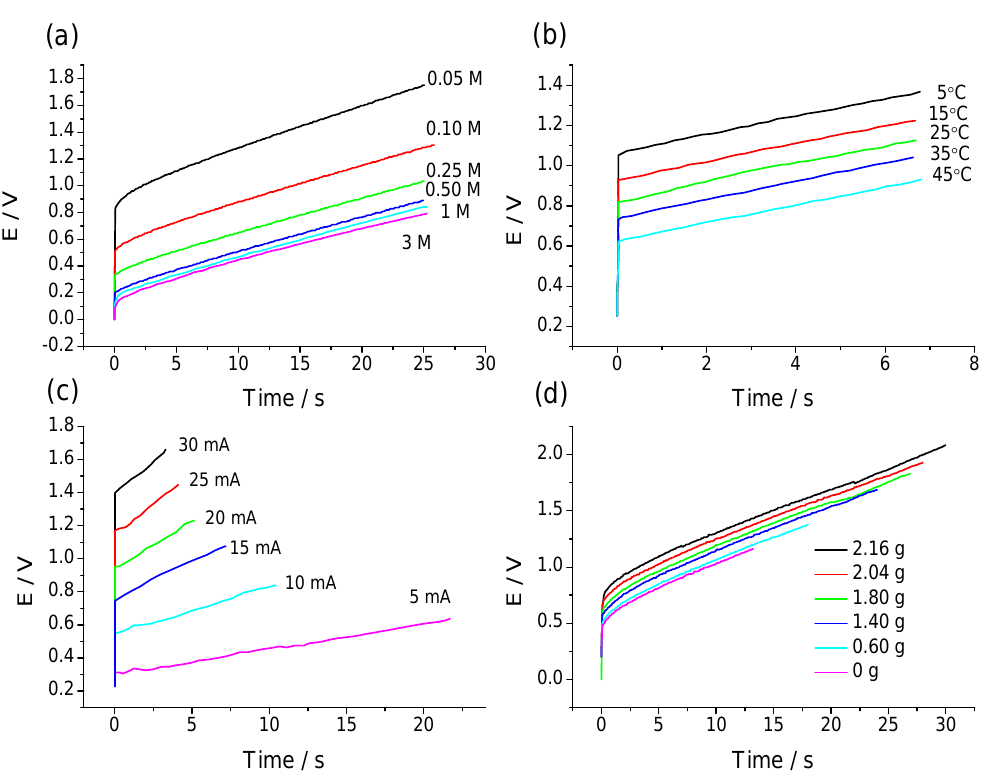
Figure 16. Chronopotentiograms obtained when a triple layer (2  1.5 cm 2 , 12 mg of PPy) (3, 1, 0.5, 0.25, 0.1, and 0.05 M) under a describes 90° (a) in aqueous solutions of LiClO 4 at different temperatures: 5, 15, 25, 35 constant current of 10 mA, (b) in 0.1 M LiClO 4 and 45 °C. (c) Under fl ow of different currents: 5, 10, 15, 20, 25, and 30 mA. (d) Shifting different attached steel weights: 0.6, 1.4, 1.8, 2.04, and 2.16 g with a device of 12 mg of polymer weight (adopted from References